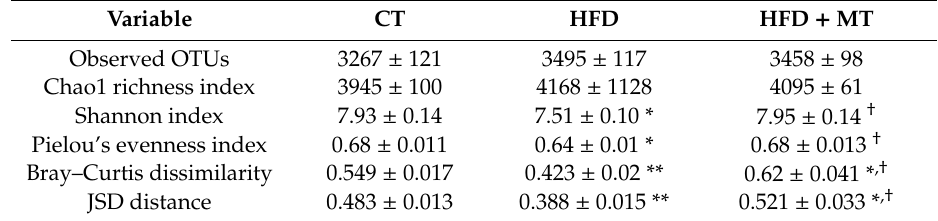
Table 2. Alpha and beta diversity indexes in rats fed a normal chow (CT) and high fat diet (HFD) and treated with the antioxidant mitochondrial MitoTempo (MT; 0.7 mg / Kg / day i.p).